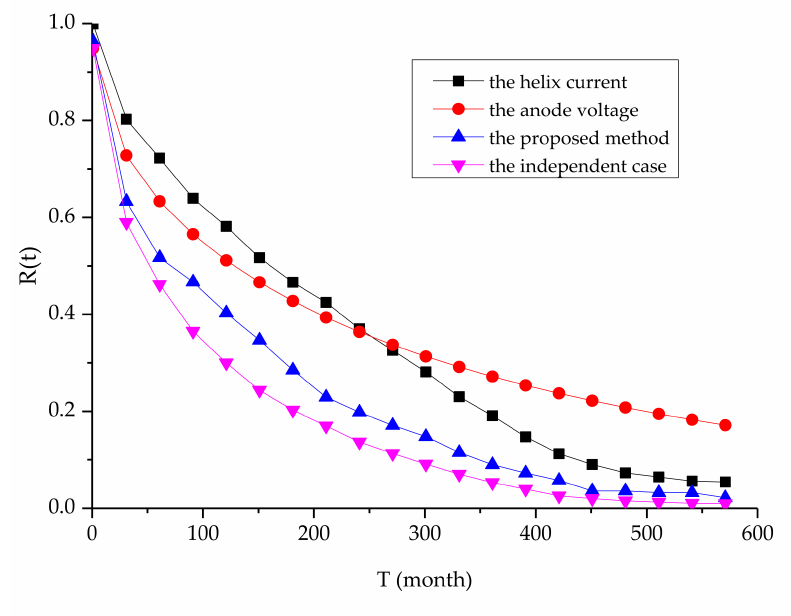
Figure 6. Reliability function curves of different